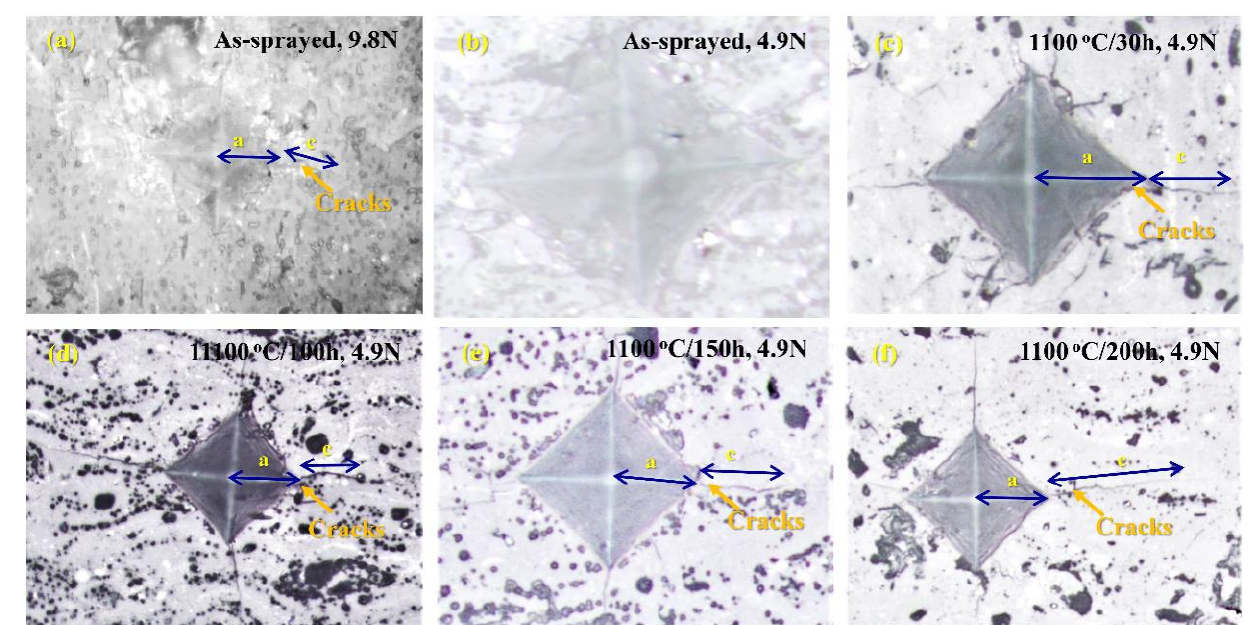
Figure 7. Cross-section morphologies with EDS results of as-sprayed ( a ), 100h ( b ) and 200h ( c ) of the CZSO coatings aged at 1100 °C.